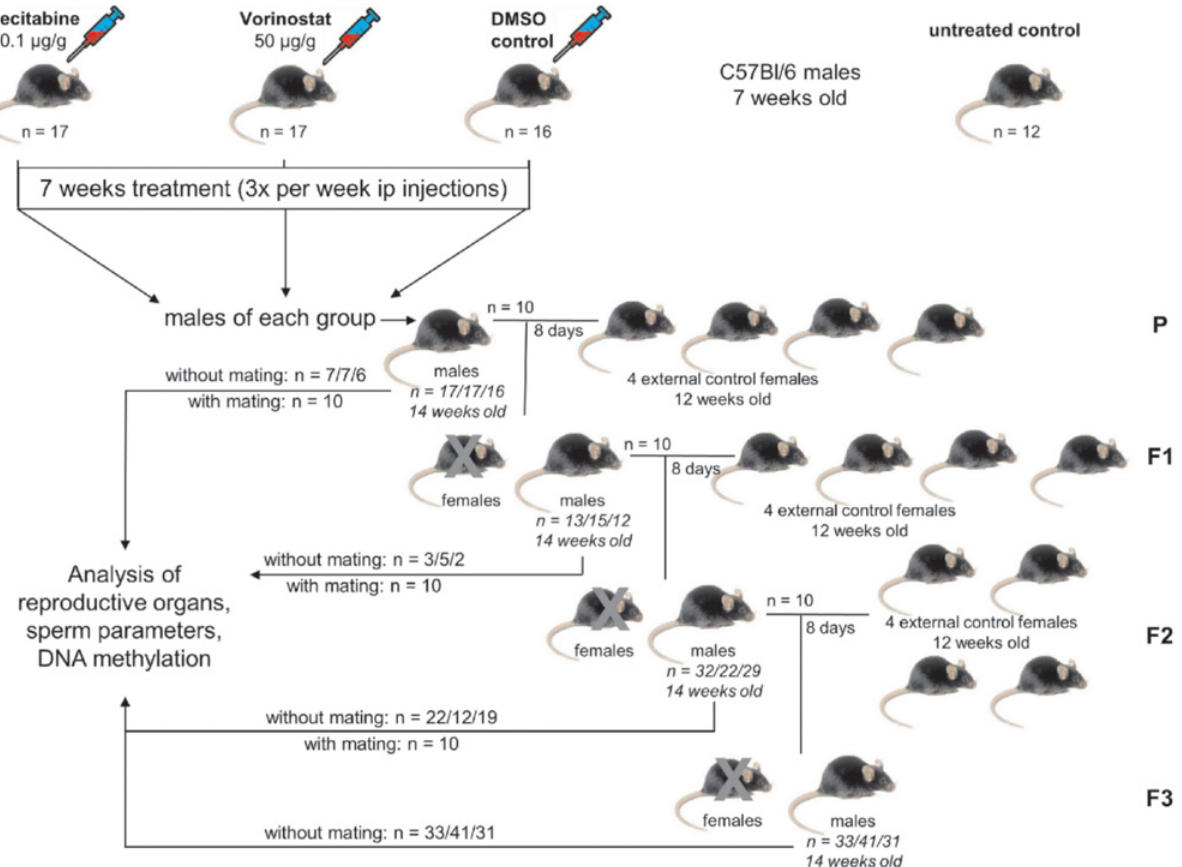
Fig 1. Study design. 62 male C57Bl/6 mice were randomly assigned to four groups receiving either drugs or DMSO or were not treated at all (decitabine, vorinostat, DMSO control, untreated control). Three times per week, mice were injected intraperitoneally for seven weeks. After treatment, 10 males from each treated group were mated simultaneously with four healthy C57Bl/6 females to produce the F1-generation. Identical mating schemes were performed for the F1- and F2-generation. After mating, all male mice of one generation were analysed. Male mice of the F3-generation were not mated but analysed directly after they reached the age of 14